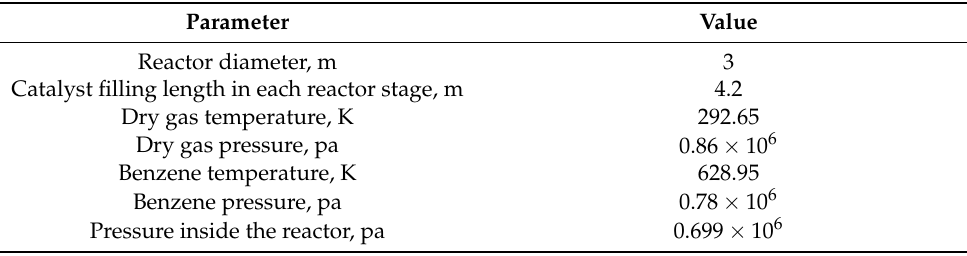
Table 2. Reactor constant